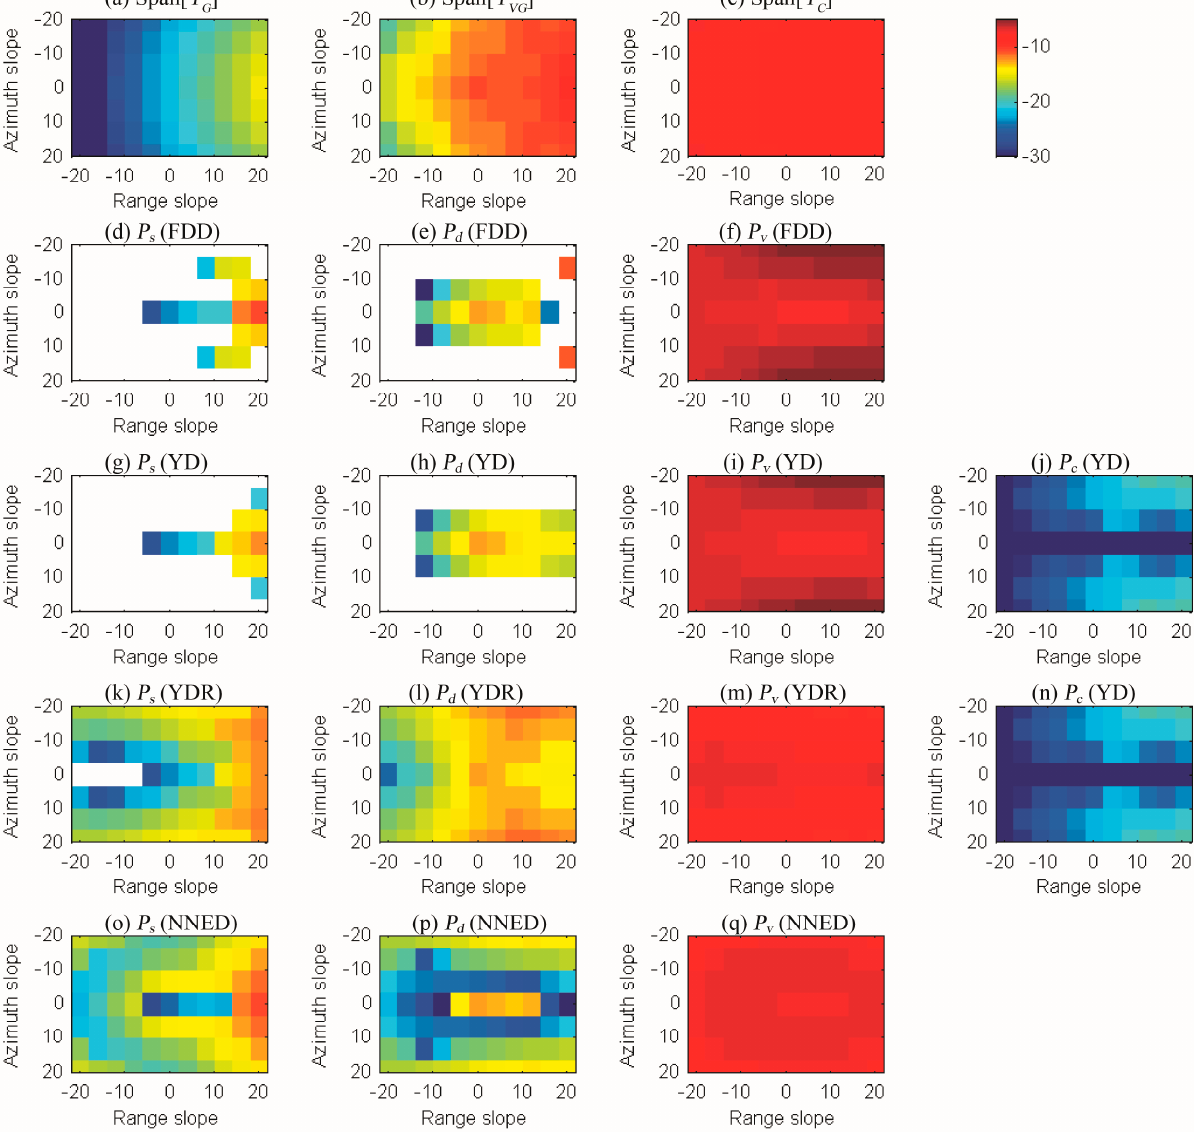
Figure 4. Changes in the scattering mechanisms with respect to the terrain range and azimuth slopes for S5. ( a – c ) Reference scattering mechanisms (ground, double-bounce and canopy scattering, respectively) of the simulated coherency matrix. ( d – f ) Calculated scattering components from the FDD method. ( g – j ) Calculated scattering components from the YD method. ( k – n ) Calculated scattering components from the YDR method. ( o – q ) Calculated scattering components from the NNED